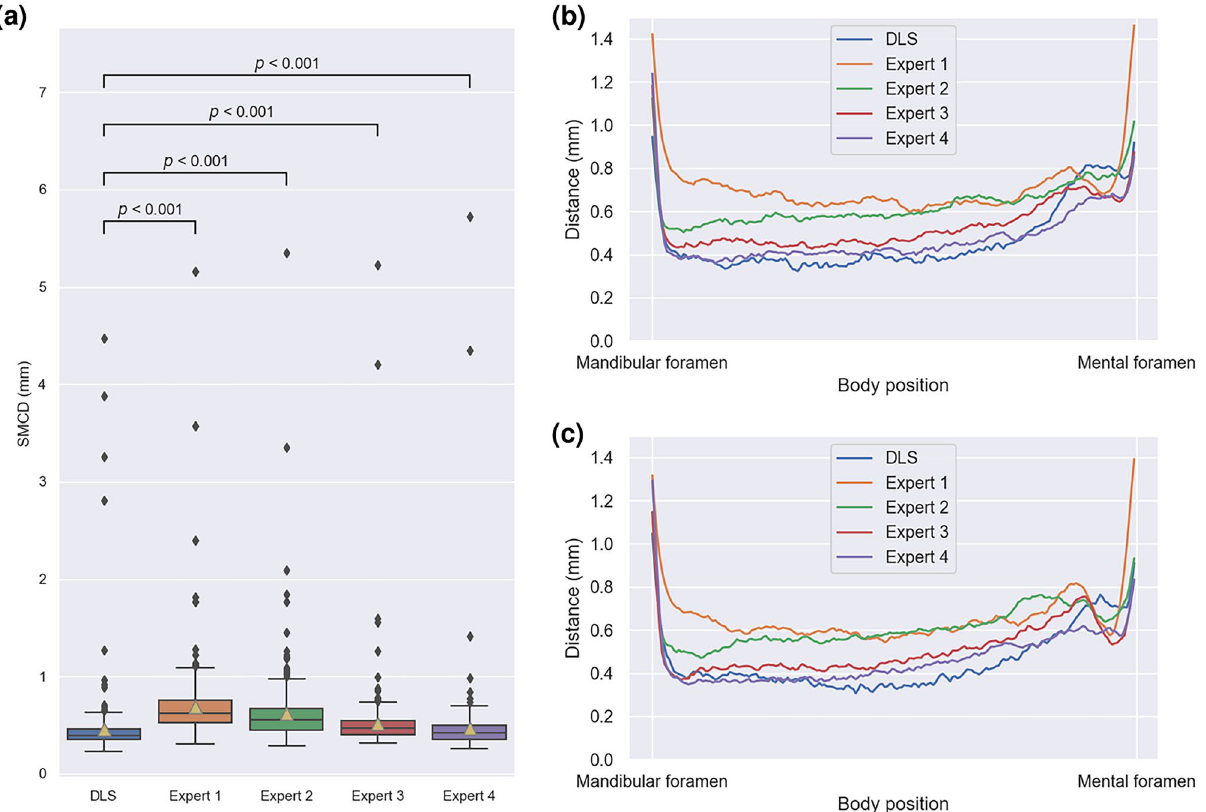
Figure 5. Measuring interobserver variability and DLS performance against a majority voted reference segmentation from expert assessments. ( a ) Tukey’s boxplot comparison of the performances of DLS and the experts against the reference segmentation. ( b ) SMCD in millimetres with respect to the approximate position of the left canals ( c ) SMCD with respect to the approximate position of the right